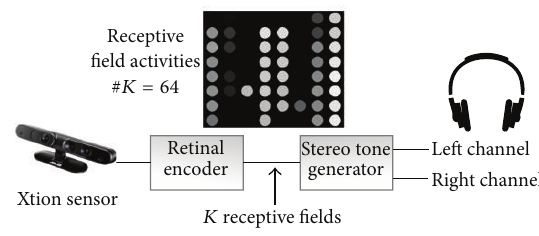
Figure 2: Visual-auditory sensory substitution flowchart. The high- input information throughput is significantly reduced before being converted into